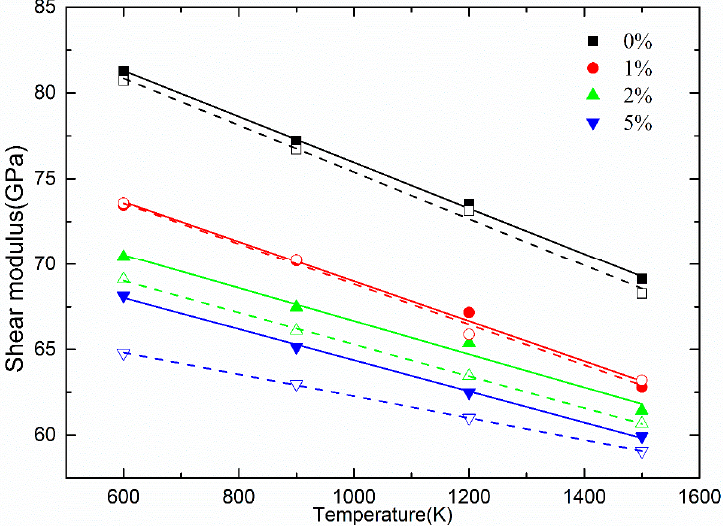
Figure 6. Variation of the shear modulus of UO 2 containing different concentrations of Frenkel (dash) and antisite (solid) defects versus temperature. The fitted lines are also included in the